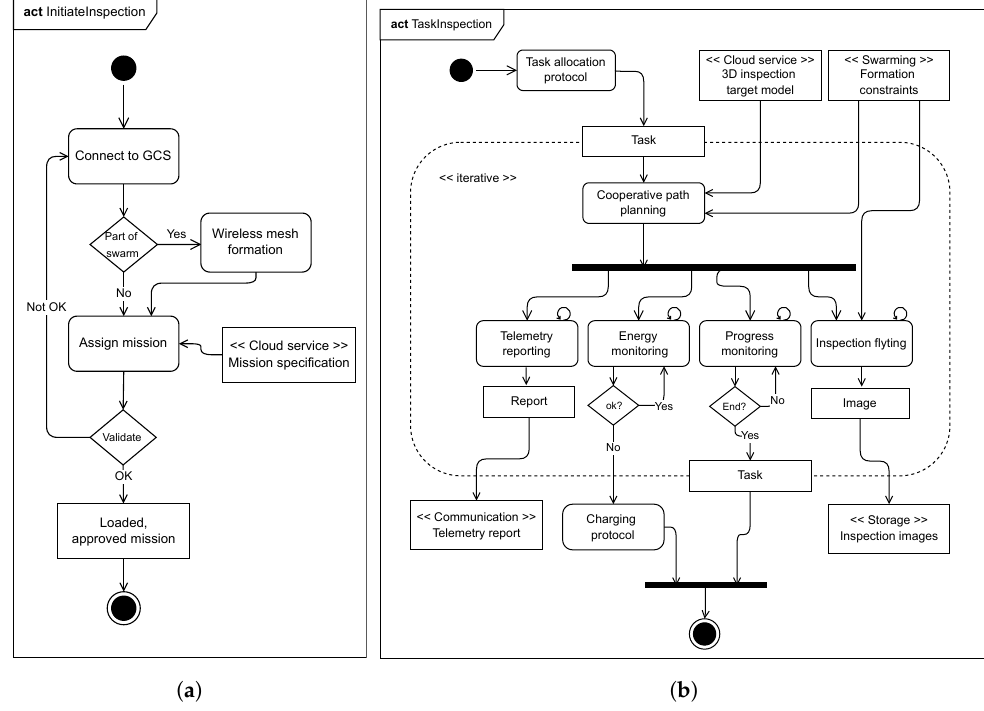
Figure 2. Activity diagrams for a drone swarm inspection. ( a ) initialization step; ( b ) task inspection step for a drone during